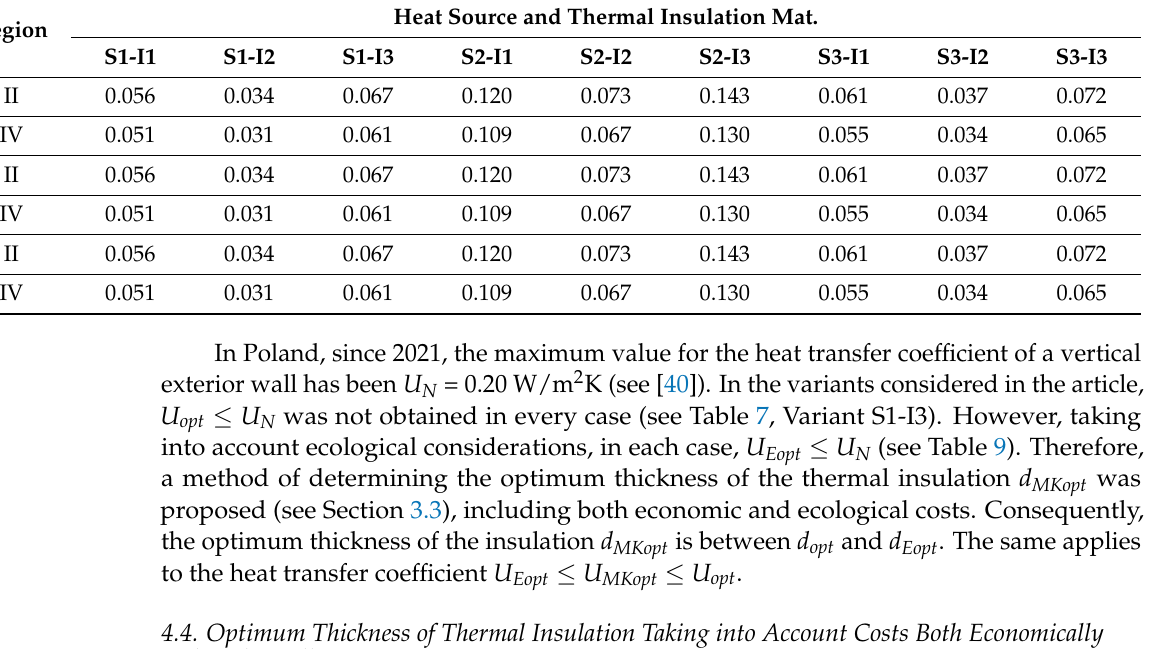
Table 9. Optimum heat transfer coefficients of the wall with a thermal insulation layer U Eopt (W/m 2 K). Constr. Region Mat.